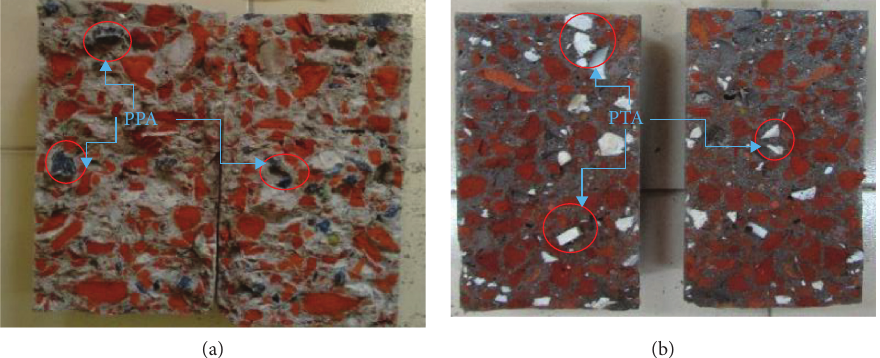
Figure 8: Failure of concrete cylinders with plastic aggregate subjected to the tensile force. (a) PPC2-42. (b) PTC2-42.